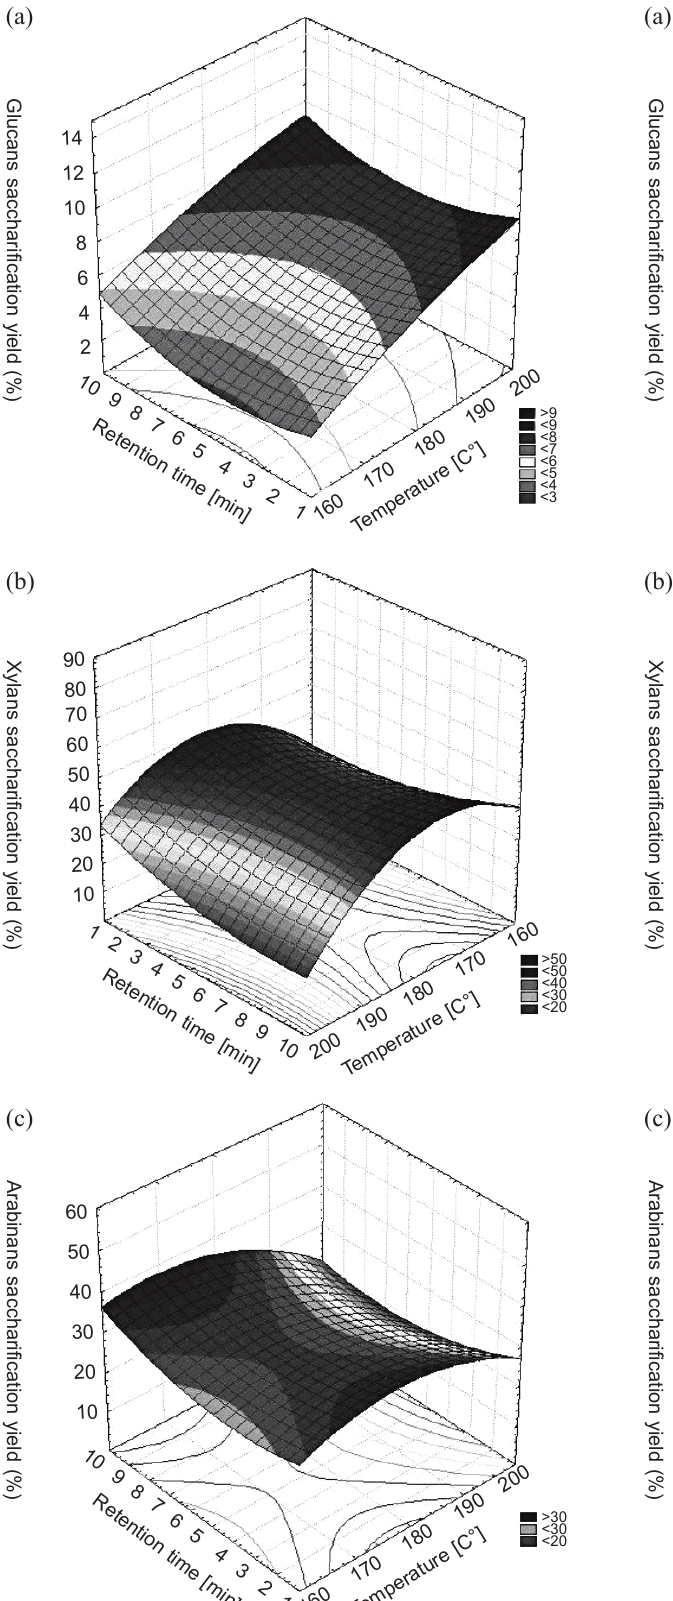
Fig. 1 – Saccharification yield of: a) glucans, b) xylans, and c) arabinans in the liquor wheat straw hydrolysate after diluted sulphuric acid (0.5 % w/w) pre-treatment by different combina- tion of hydrolysis process parameters in the